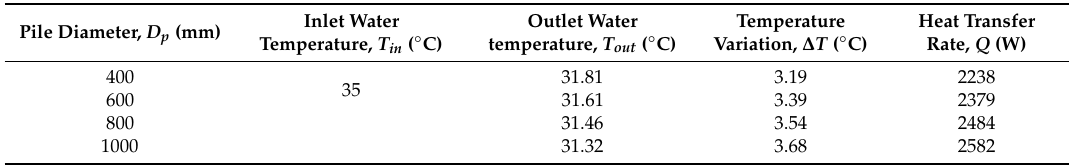
Figure 12. Outlet water temperature variation for different pile diameters, D p . Table 10. Simulation results for different pile diameters, D p (keeping all other values consistent with the reference values in Table 8).